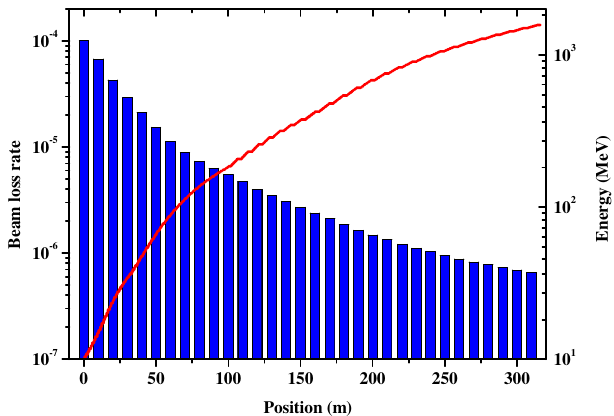
FIG. 1. Maximum allowable lost particles rate per 10 meters in the main linac